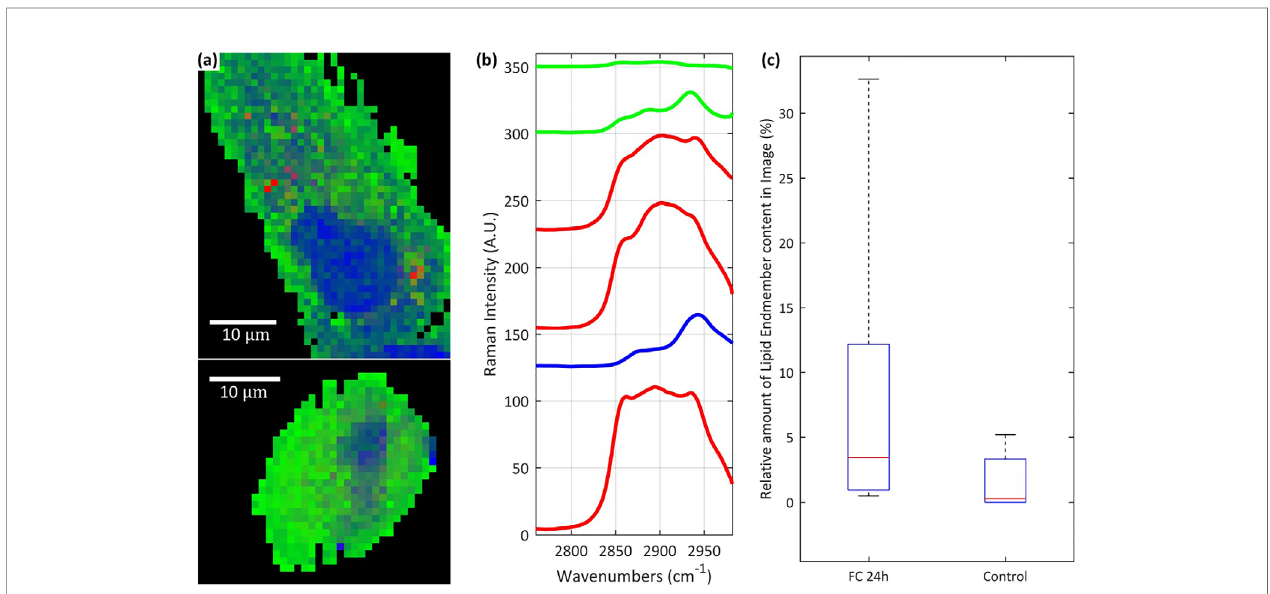
FIGURE 4 | Raman analysis of lipid content in cells. Representative examples of false colour images (A) of falcarindiol (FaDOH) 24 h cell (upper) and control cell (lower) produced using the spectral unmixing algorithm N-FINDR on the combined set of spectral data containing all FaDOH 24 h cells and control cells. The unmixing analysis was focused on the CH-stretch spectral region along with 6 endmembers (B) . Box plot representing relative amount of lipid content in FaDOH 24 h (FC 24h) and control cells (C) calculated using relative area quanti fi cation on the false colour images and an abundance value threshold of 0.2. The lipid content in cells is identi fi ed using the red endmember spectra in (blue and green represent nucleus and cytoplasm respectively) (B) . Scale bars are 10